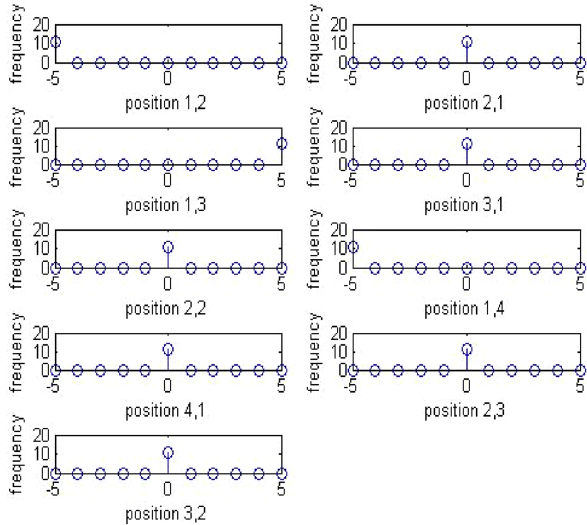
Figure 9. Dual histogram of sample calibrated stego image.